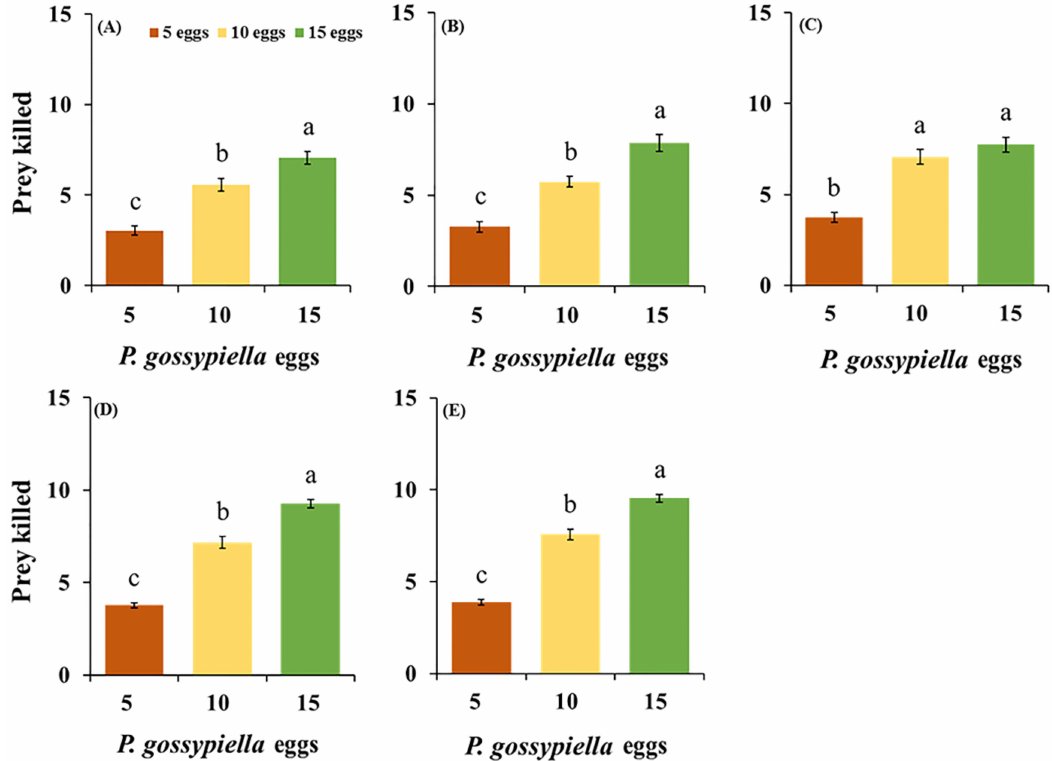
Figure 1. Feeding potential of the predatory stages of the O. strigicollis on three di ff erent densities of P. gossypiella eggs (5, 10 and 15) after 24 h, ( A ) = 3rd instar, ( B ) = 4th Instar, ( C ) = 5th Instar, ( D ) = Male, ( E ) = Female. Di ff erent letters above each bar indicate significant di ff erences between three treatments using one-way ANOVA, LSD test, p = 0.05 and n =